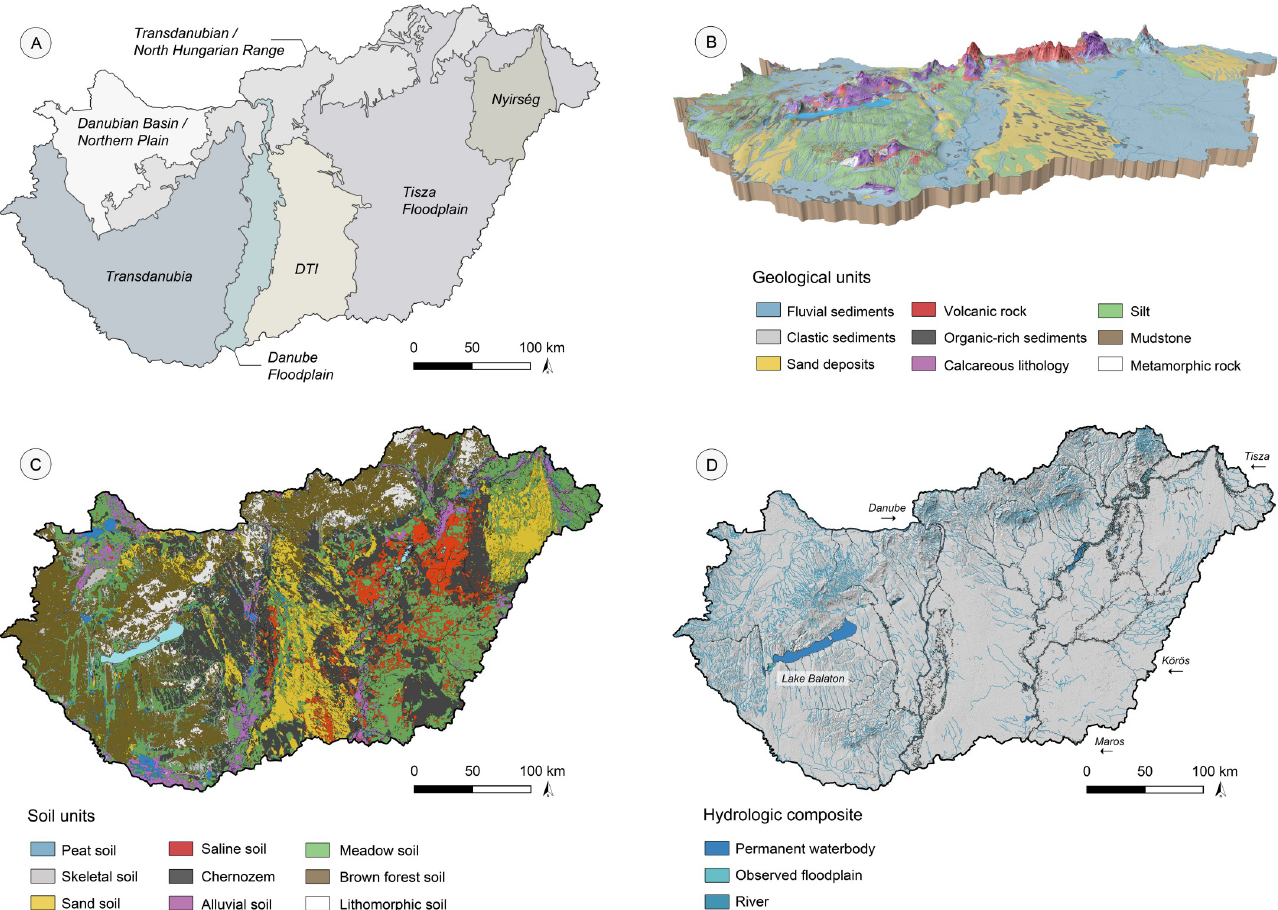
Fig 2. Environmental settings of modern Hungary. (A) Regional classification based on geological, hydrological, and pedological settings [16]; (B) 3-D model of the geological and topographical parameters (30-times vertical exaggeration) [65, 66]; (C) soil units in Hungary [57, 67]. For the translation to the WRB system see [26, 52, 53]; (D) hydrologic composite based on the observed floodplain extent [68], permanent waterbodies, and the modern river system.